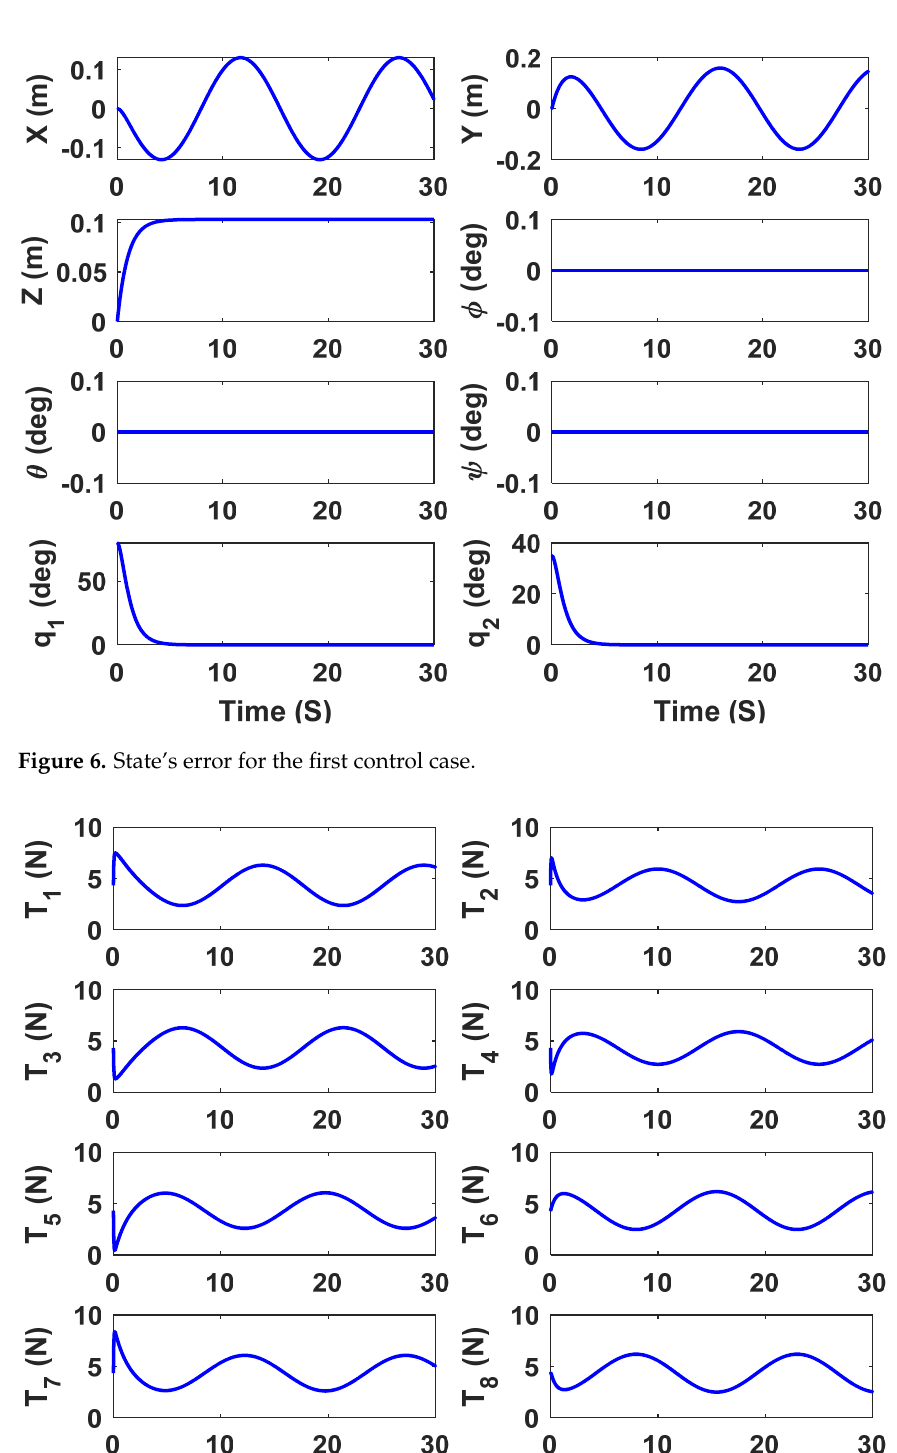
Figure 5. States of ACMS for the first control case (reference: red).